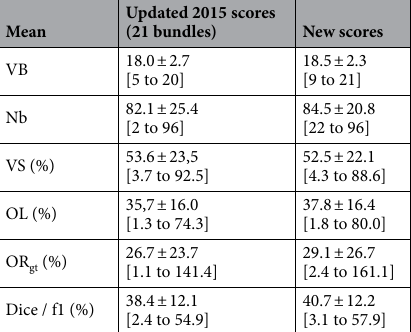
Bundle (L/R = left / right)